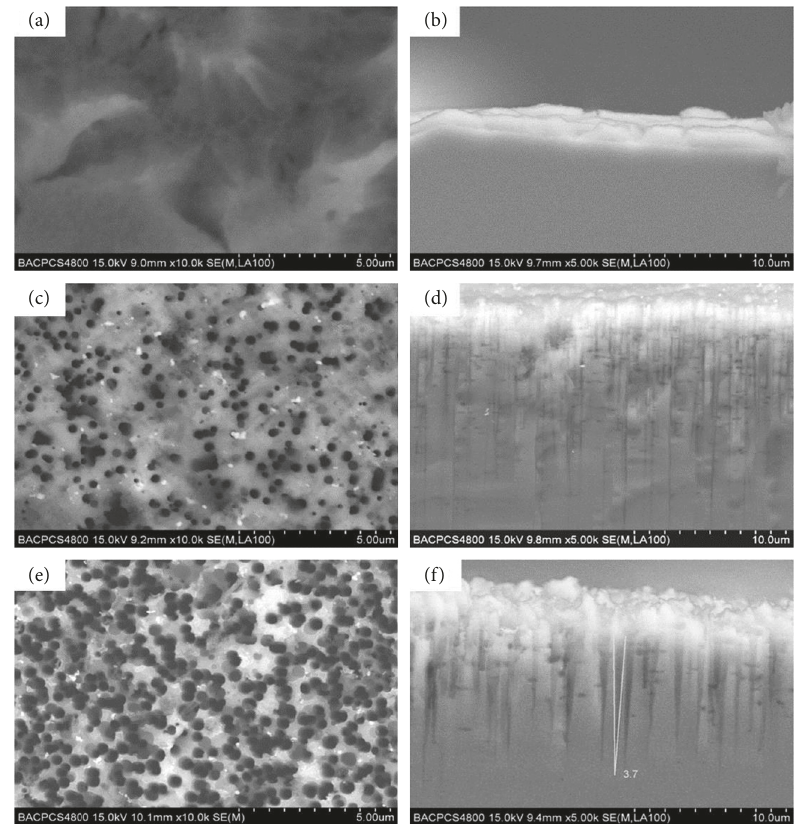
Figure 11: The plan and cross section SEM images of the etched c-Si surface obtained by single electrochemical etching (ECE), single metal- catalyzed electroless etching (MCEE), and metal-catalyzed electrochemical etching (MCECE) in HF/H 2 O 2 /H 2 O solution with the volume ratio of 3:10: 24 for 60min. (a) and (b): ECE with the galvanostatic condition (the current density of 5.7 mA/cm 2 ). (c) and (d): MCEE with the Ag particle catalyst. (e) and (f): MCECE with the galvanostatic condition (the current density of 5.7 mA/cm 2 ) and the Ag particle